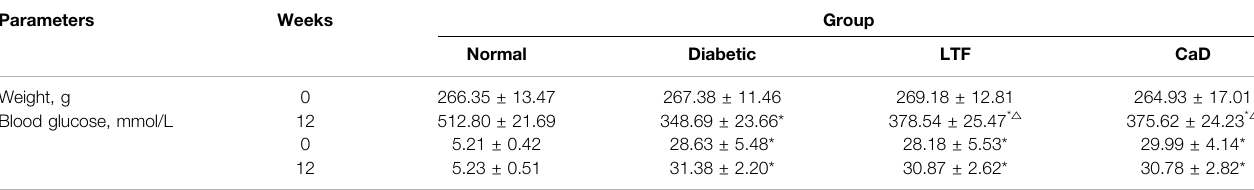
Frontiers in Pharmacology |